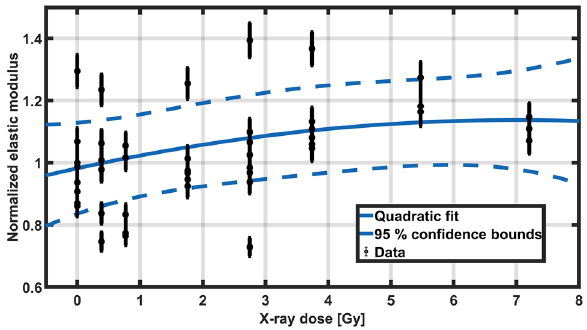
10 B to X-ray beams.